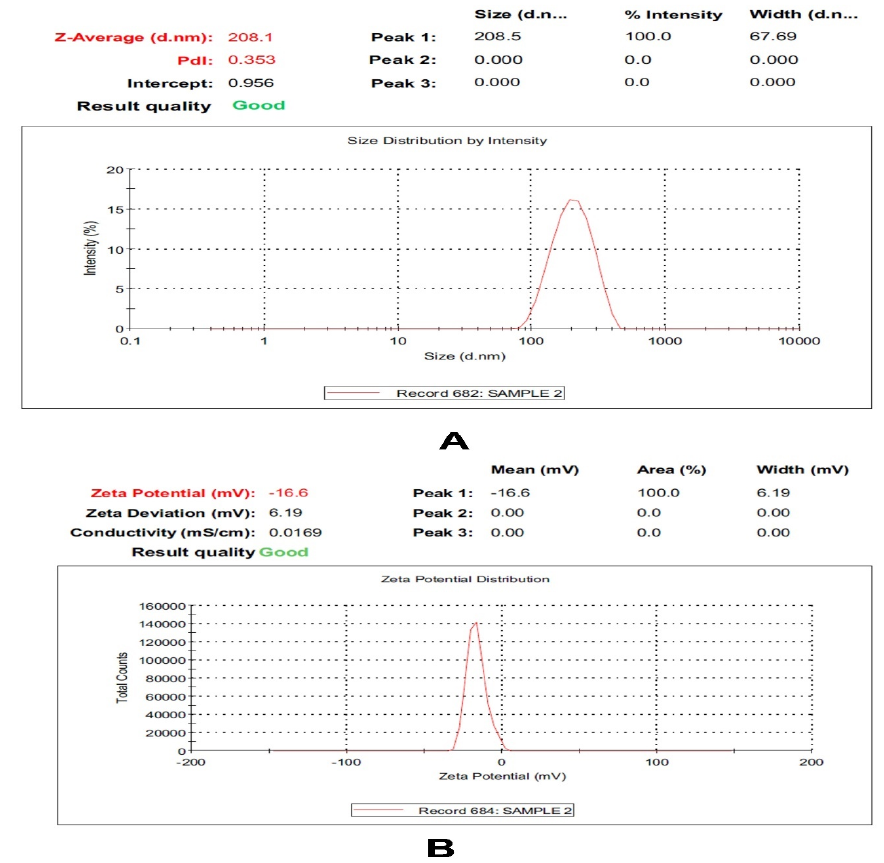
Figure 1. Particle size distribution and zeta potential of Citrus lemon essential nanohexosomes.